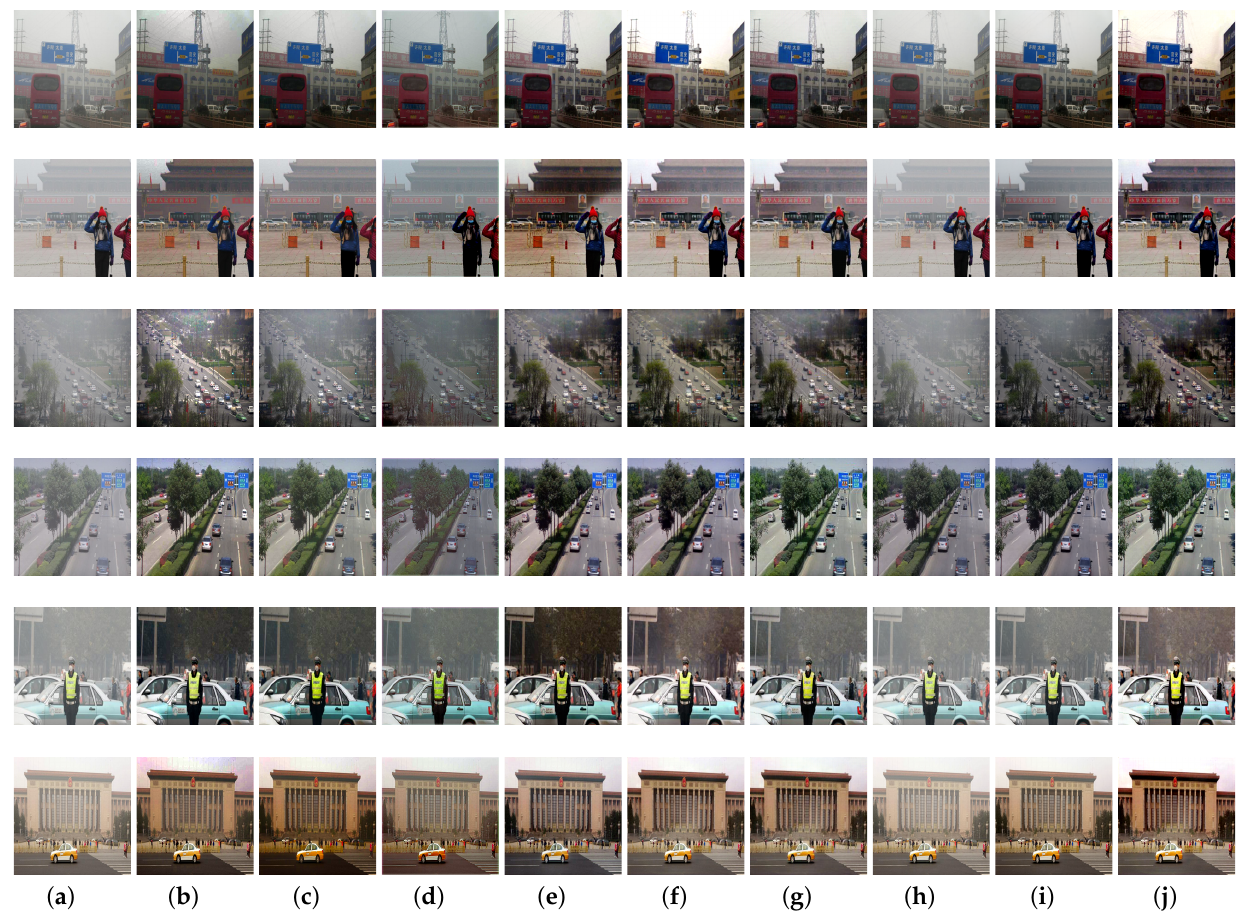
Figure 11. Visual comparisons on real-world images. ( a ) Hazy images. ( b ) DCP. ( c ) CAP. ( d ) AODNet. ( e ) EPDN.